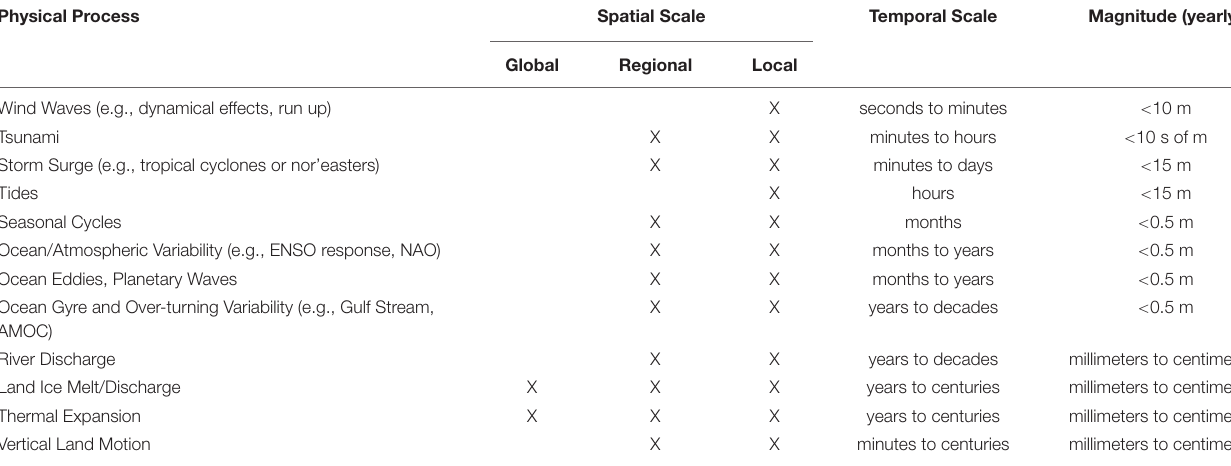
TABLE 1 | Spatial and temporal scales of geophysical processes affecting water